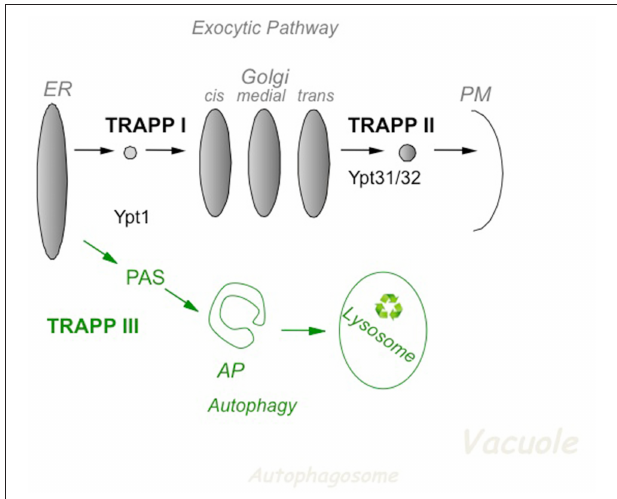
FIGURE 2 | The role of TRAPP complexes and their Ypt substrates in yeast intra-cellular trafficking. In the exocytic pathway (top), TRAPP I activates Ypt1 to regulate ER-to-Golgi transport, whereas TRAPP II activates Ypt31/32 to regulate Golgi-to-PM transport. In autophagy (bottom), a cellular recycling pathway (in green), TRAPP III activates Ypt1 to regulate the assembly of PAS, the first step of autophagy. PAS is required for the formation of the double-membrane autophagosome (AP), which delivers cargo for degradation in the lysosome. See discussion in the